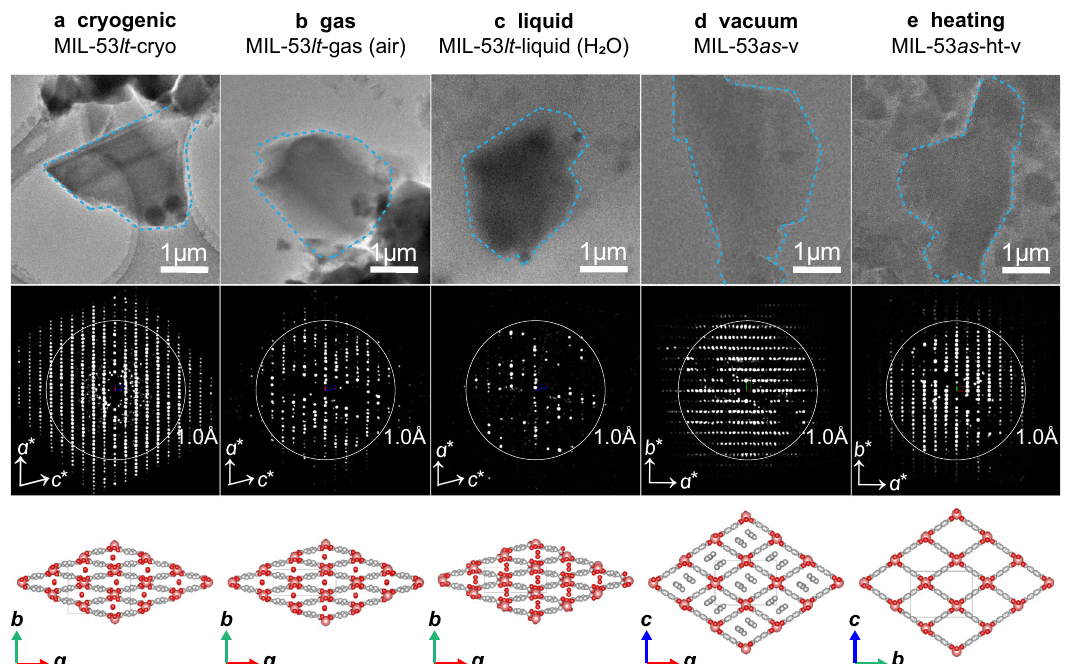
Fig.2|TEMimages,environmental3DEDdataanddeterminedstructuresfrom singlecrystals(MIL-53)underdifferentconditions. The3DEDdataareprojected alongthe( a-c )[010]and ( d , e )[001]directions.Eachprojectionisfromasingle 3D ED dataset without data merging. a MIL-53 lt -cryo: the low temperature phase